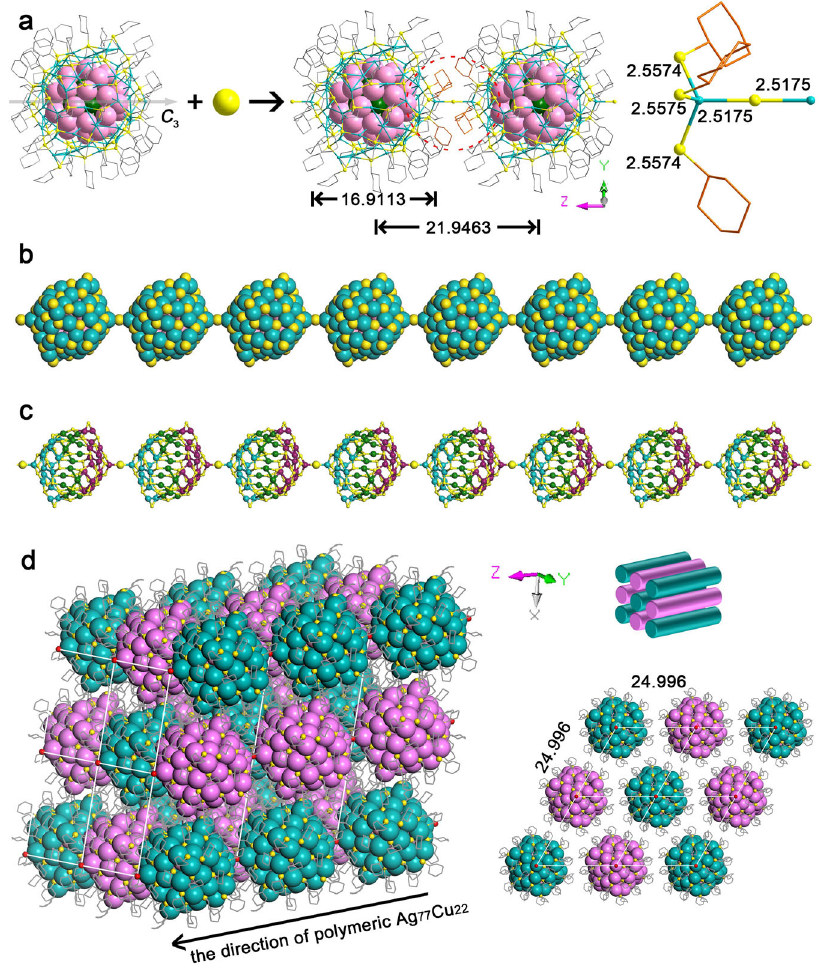
Fig. 3 | Polymeric structure of Ag 77 Cu 22 NCs. a The linkage of Ag 77 Cu 22 NCs (H atoms are omitted for clarity). b Space- fi lling view of the Ag 77 Cu 22 chain (C and H atoms are omitted for clarity). c The arrangement of Ag 56 S 48 shells along the Ag 77 Cu 22 chain(CandHatomsareomittedforclarity). d 3DframeworkofAg 77 Cu 22